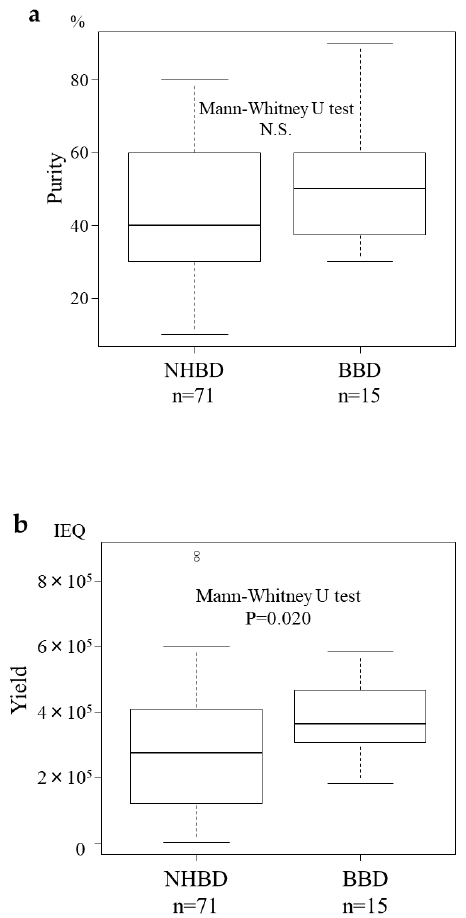
Figure 7. Comparison of the outcomes of islets isolatation from brain-dead donors (BDDs) and non-heart-beating donors (NHBDs). The median islet purity ( a ) and pancreatic islet yield ( b ). While the median purity after isolation did not differ to a statistically significant extent between the groups, the median pancreatic islet yield was 362,700 islet equivalents (IEQ 180,715–583,333) in the BDD group ( n = 15) and 275,550 IEQ (400–885,608) in the NHBD group ( n = 71), which amounted to a significant difference.